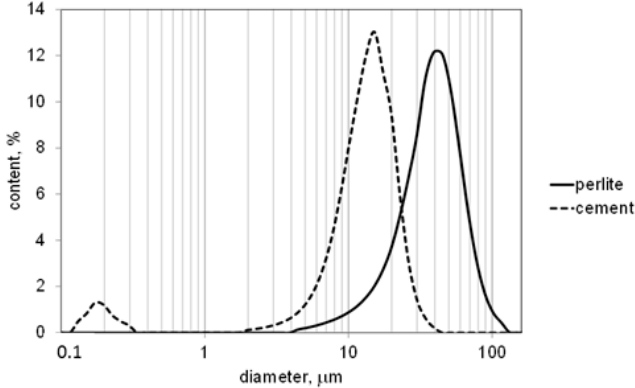
Figure 1. Grain size distribution of the waste perlite powder.